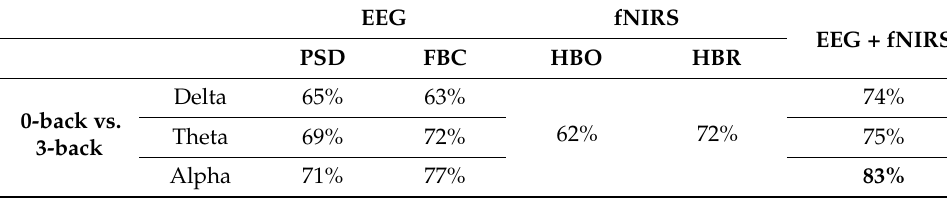
Table 2. SVM classification accuracy of 0 ‐ back vs. 2 ‐ back using different features.